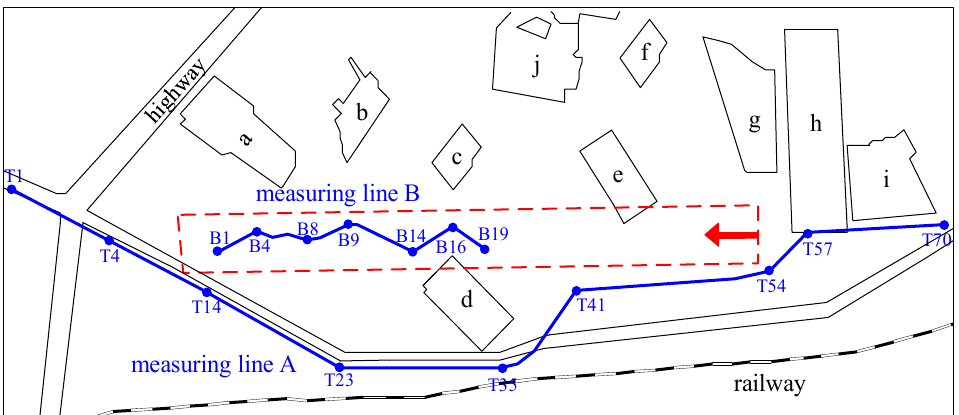
Figure 14. Measuring line layout.